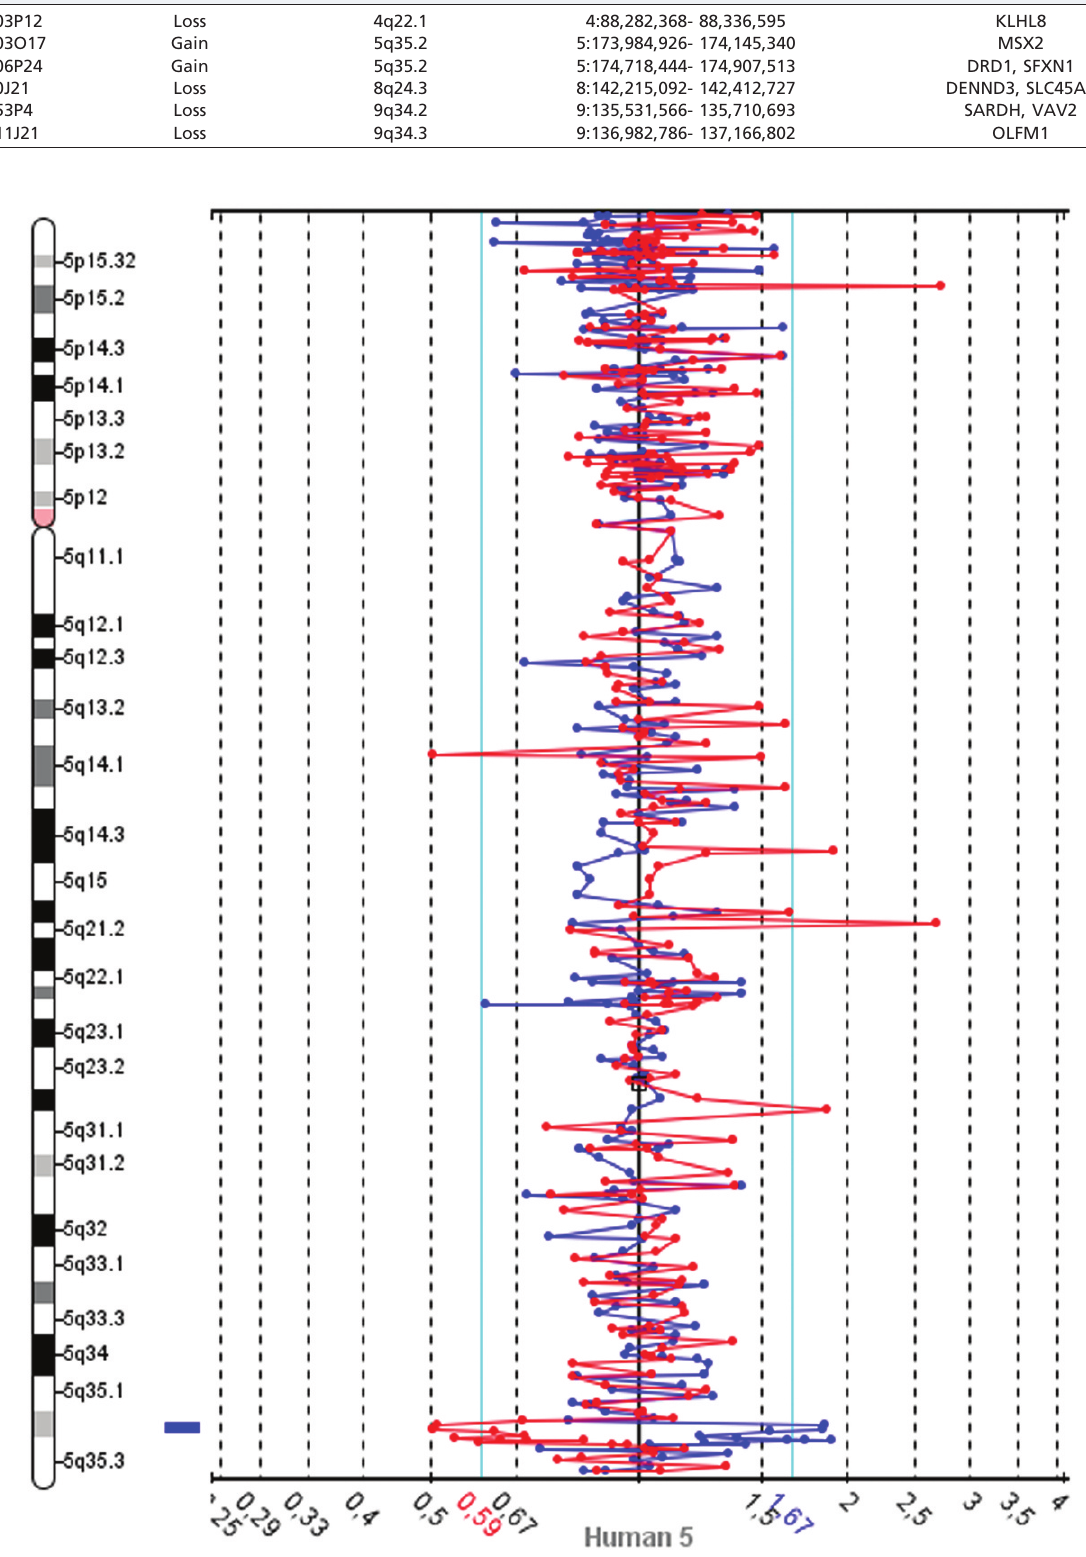
Figure 1 - A spectral image of chromosome 5 from the patient revealing a gain in 5q35.2, which was detected by